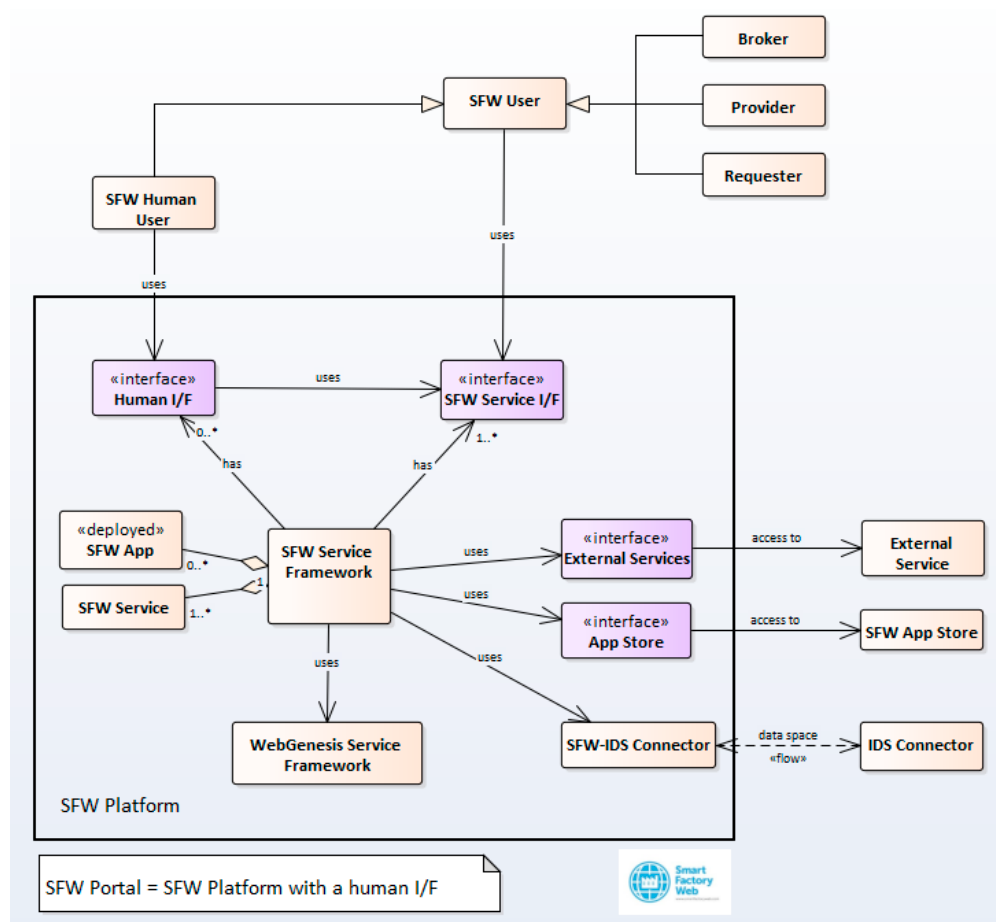
Figure 3. Smart Factory Web architecture.